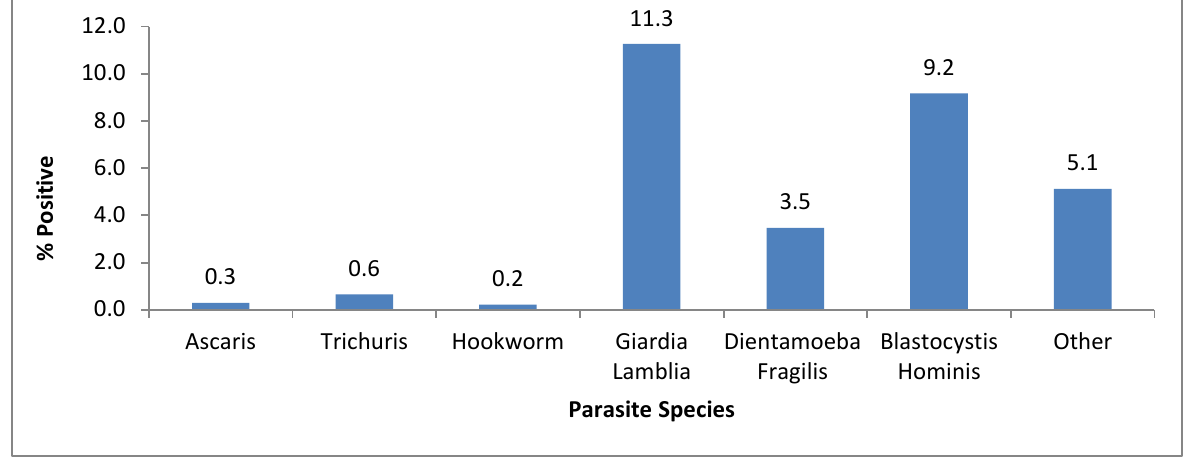
Figure 9: Parasites identified by stool ova and parasite examination in Congolese refugees during domestic medical examinations in 4 states from 2010 – 2013